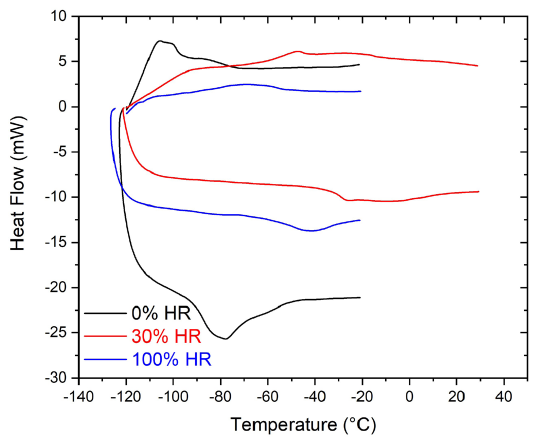
Figure 4 - DSC of Cu-Al-Be-Cr alloy alloy.